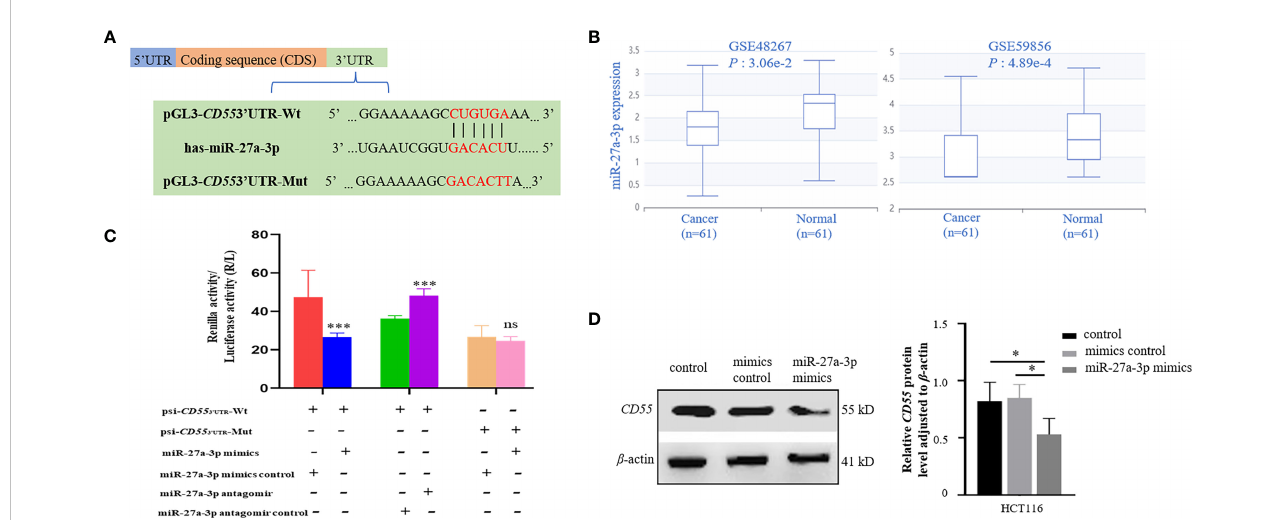
FIGURE 4 Binding and regulation of miRNA to CD55 3 ′ UTR. (A) TargetScan and starBase v2.0 database predicted miR-27a-3p binding site in the 3 ′ UTR of CD55. (B) The differential expression of miR-27a in two colon cancer GEO datasets ( p < 0.05). (C) Veri fi cation of the potential binding of miR-27a-3p mimics or antagomir with CD55 using luciferase reporter assay. The luciferase reporter activity of CD55 3 ′ UTR reduced by miR-27a-3p mimics and increased miR-27a-3p antagomir ( p < 0.001). The relative luciferase activity was normalized to the Renilla luciferase activity. Each experiment was performed in triplicate. Data are presented as the mean value ± SD (* p < 0.05; ** p < 0.01; *** p < 0.001, ns, no signi fi cance). (D) The protein expression of CD55 in HCT116 cells determined by Western blotting and densitometry analysis after cells were transfected with or without miR-27a-3p mimics (negative control) or with mimics control for 48 h (* p < 0.05). GEO, Gene Expression